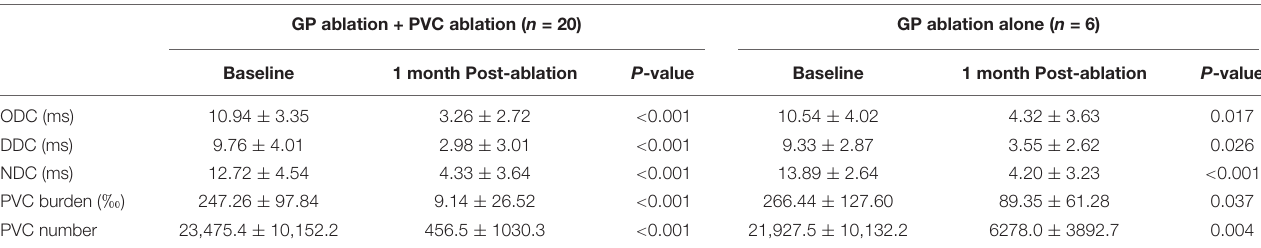
TABLE 4 | Effect of catheter ablation on PVCs burden and